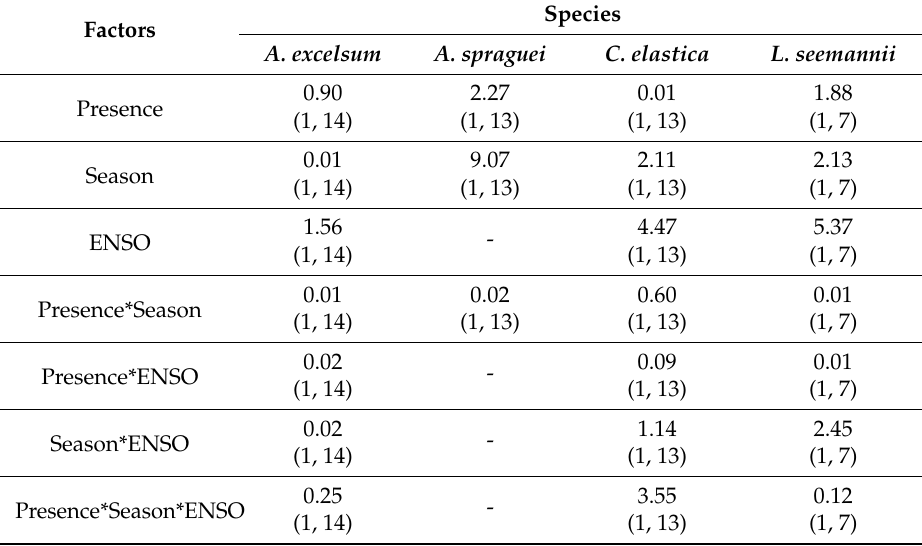
Table 1. Effect of the liana presence, season, ENSO year, and their interaction on the displayed leaf temperature of tropical trees. Values represent F-ratios and values in parentheses describe the degree of freedoms; no statistical significance was